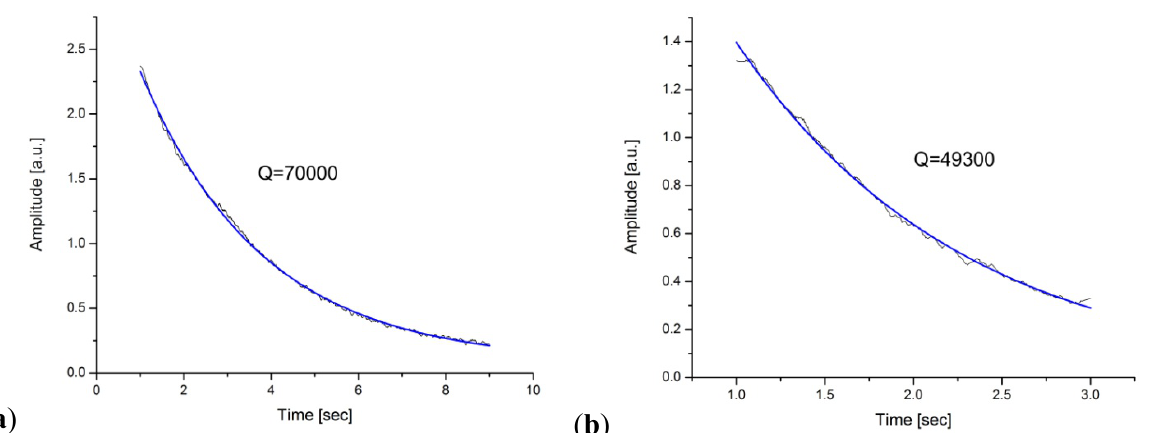
Figure 11. Resonance amplitude decay plots of ( a ) Design #3 ( b ) Design #4.